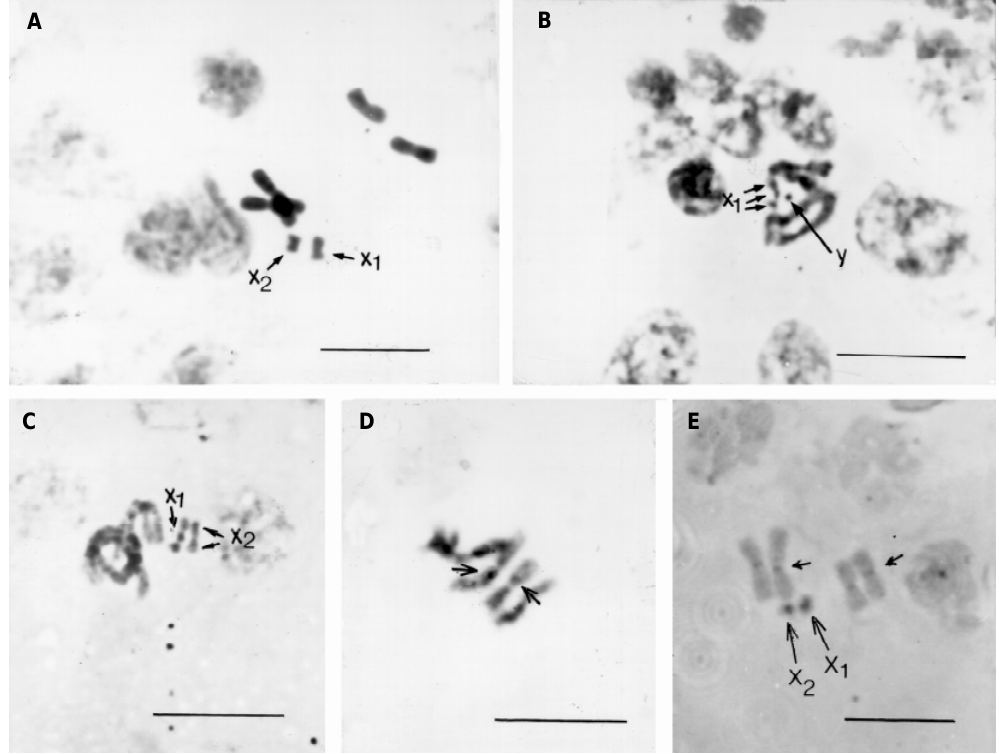
Figure 3 - Metaphase karyotypes from larval neuroblast cells of Anopheles nuneztovari . A = Female from Macapá; B = male from Manaus; C, D = females from Manaus; E = female from Macapá. Short arrows = centromeric markings. Bar = 10 m m.